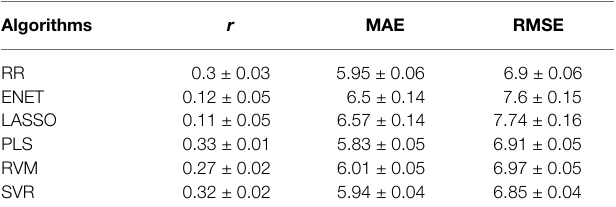
TABLE 1 | Performance of predictive models based on classical feature selection with GSR and scrubbing. Algorithms